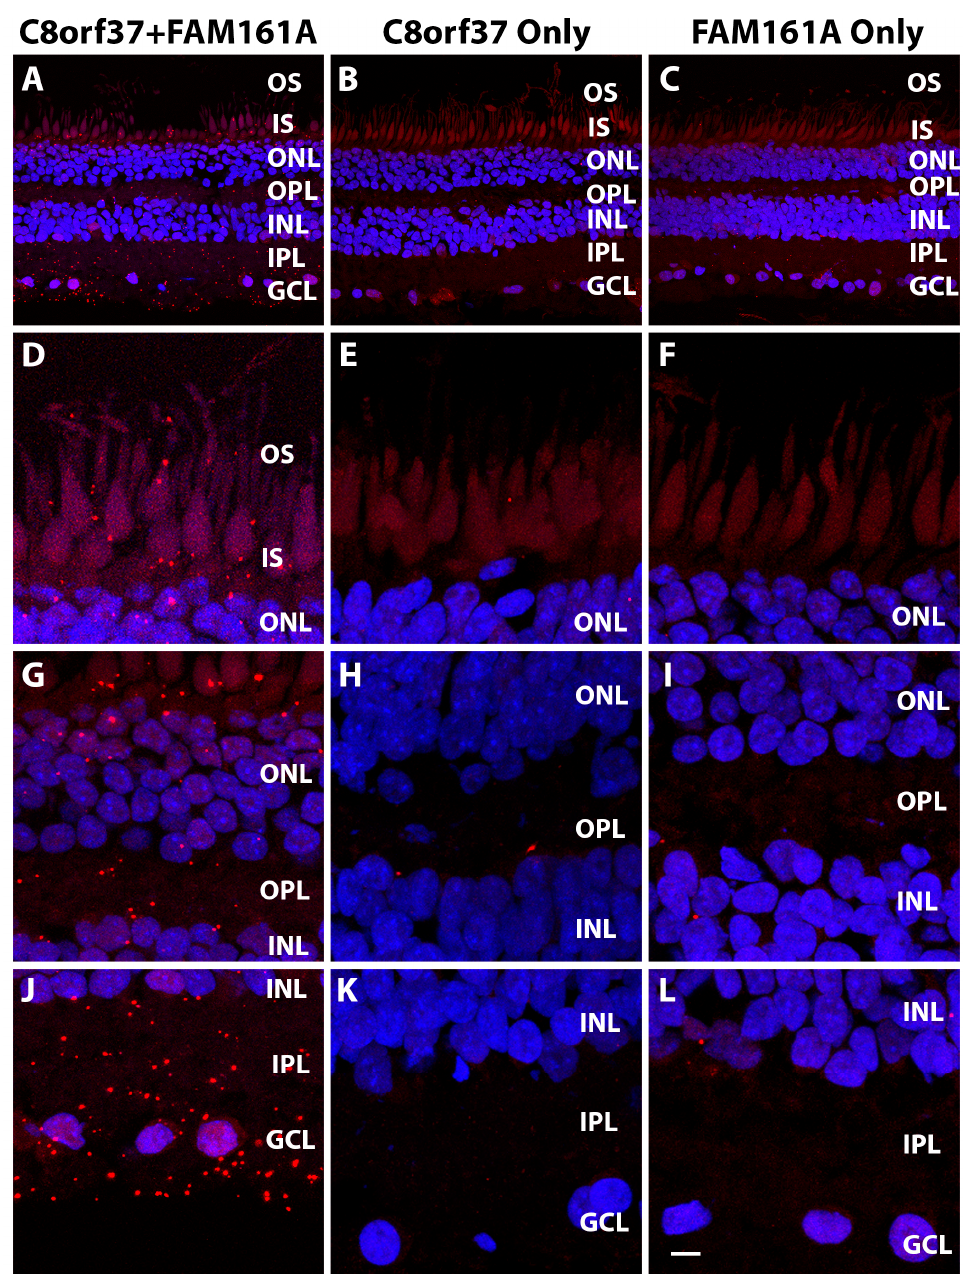
Figure 2. Proximity ligation assay of C8orf37 and FAM161A in the marmoset retina. Proximity ligation assay with Duolink In Situ Probemaker PLUS-labeled anti-C8orf37 and Duolink In Situ Probemaker MINUS-labeled FAM161A was performed on marmoset retinal sections, showing: ( A , D , G , J ) PLA with both anti-C8orf37-PLUS and anti-FAM161A-MINUS probes; ( B , E , H , K ) Anti-C8orf37-PLUS probe alone; ( C , F , I , L ) Anti-FAM161A-MINUS probe alone. Note the PLA signals observed in the retina when both probes were used. Few signals were observed when anti-C8orf37 and anti-FAM161A were used alone. Scale bar in L: 20 µ m for ( A – C ); 6 µ m for ( D – L